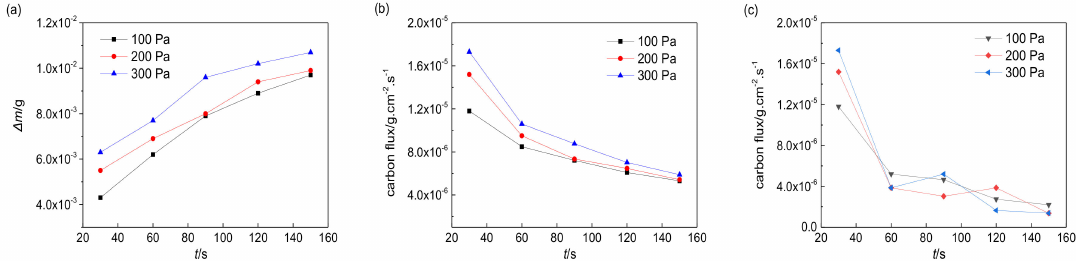
Figure 8. E ff ect of carburizing pressure on ( a ) mass increment, ( b ) average carbon flux, and ( c ) segmented average carbon flux for 16Cr3NiWMoVNbE steel at 950 ◦